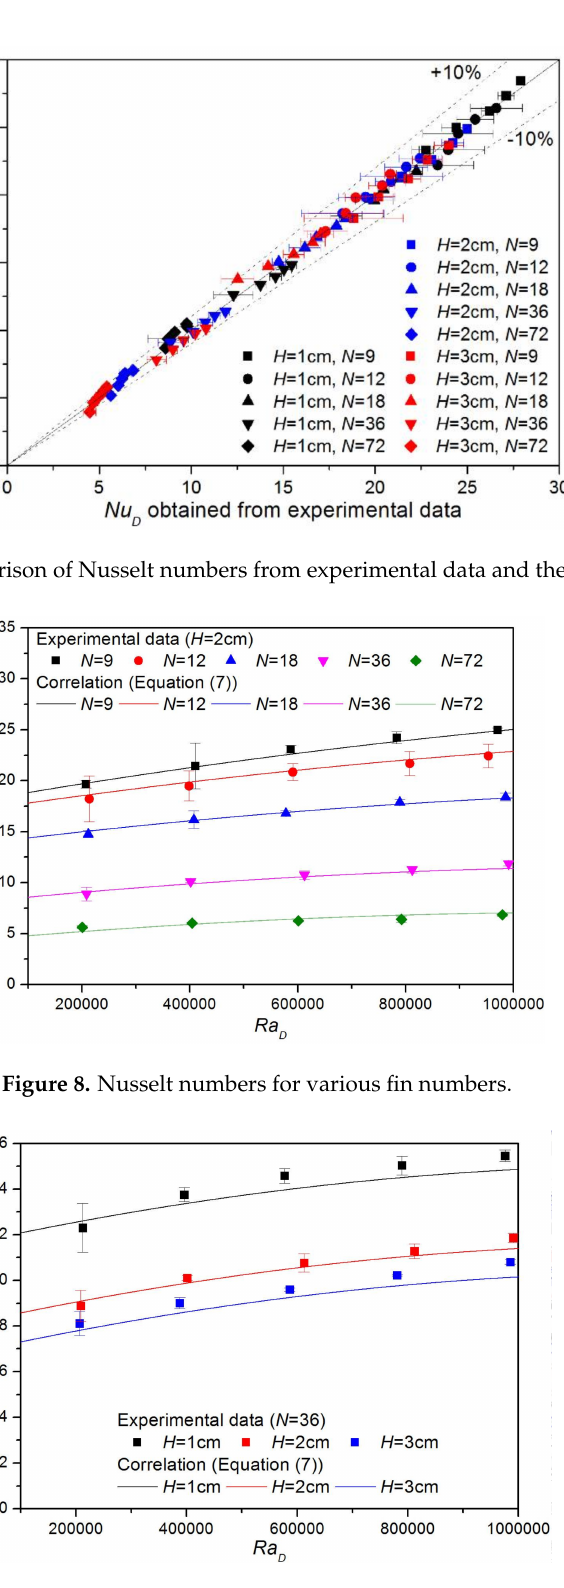
Figure 9. Nusselt numbers for various fin